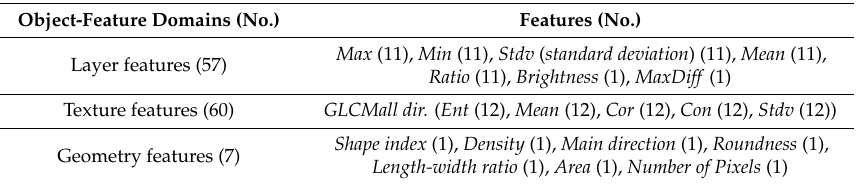
Table 2. Object features used in this